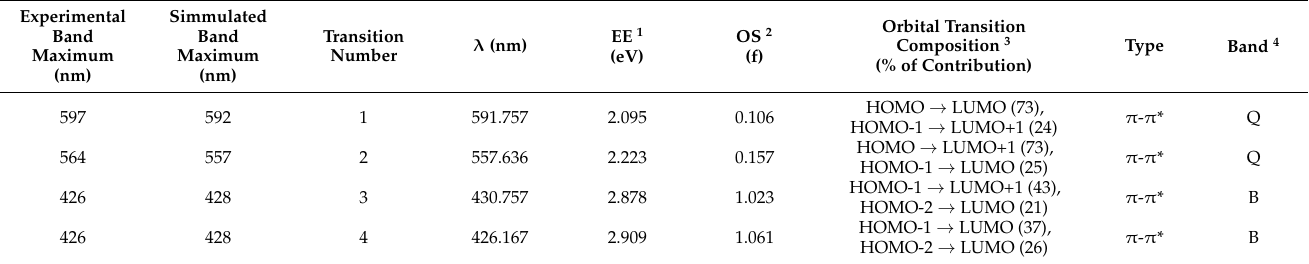
The essential vertical excitations of 3 at the PCM/TD-DFT/PBE1PBE/6-